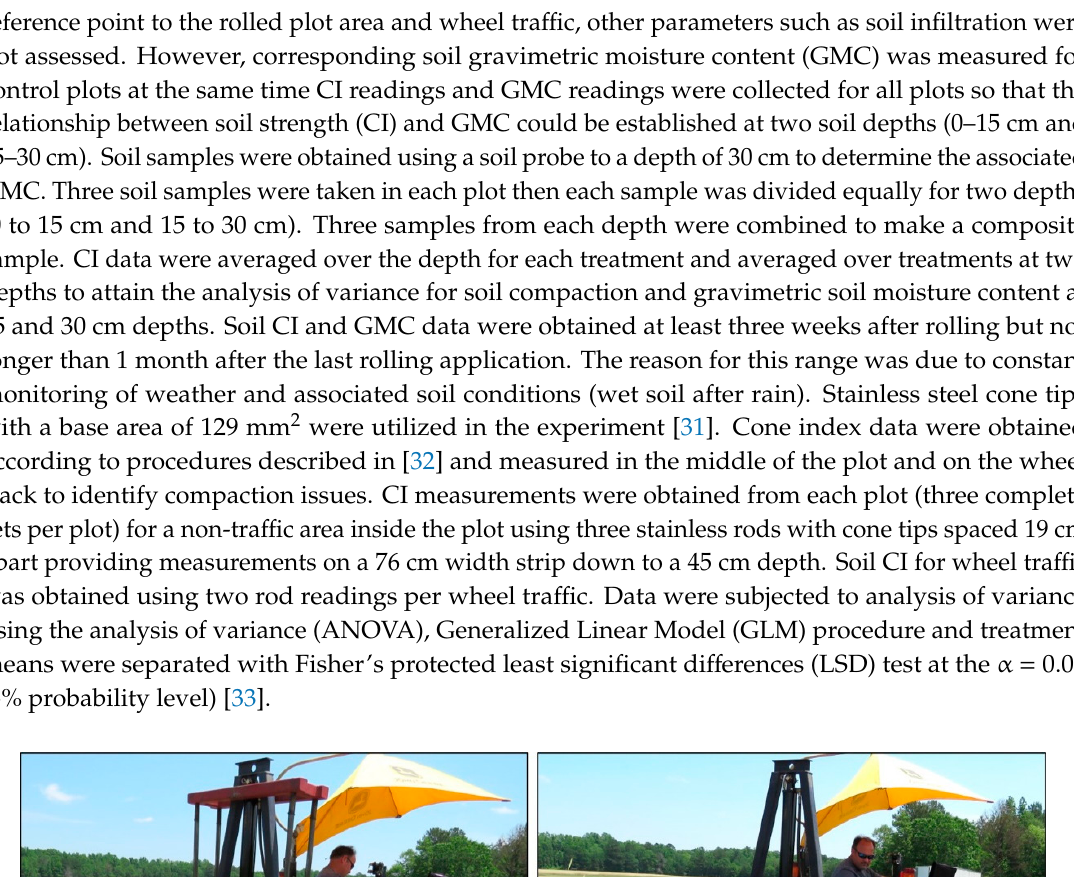
Table 2. Analysis of variance results for cereal rye biomass production, kill rates and seed cotton yield.